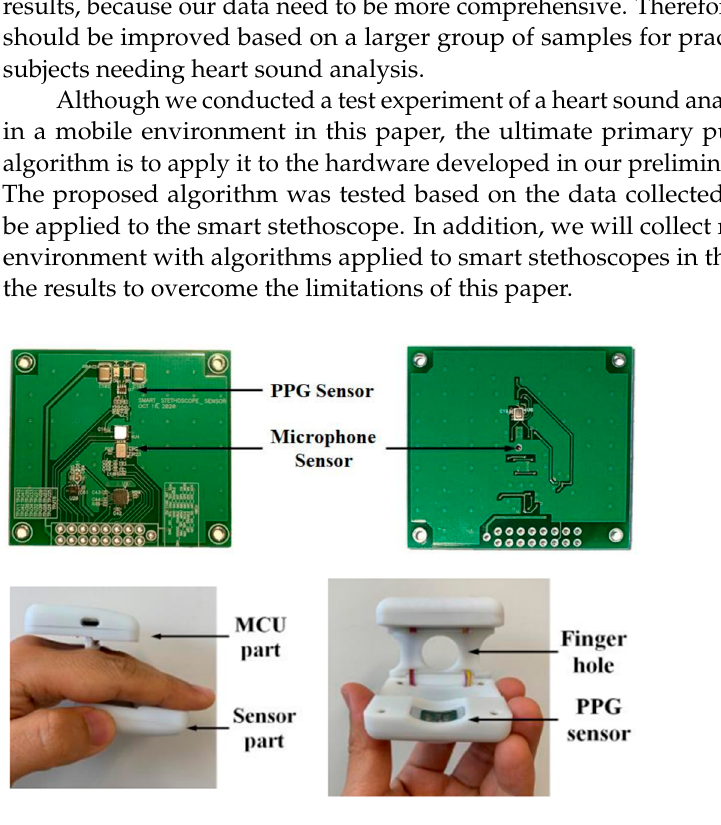
Figure 8. Our preliminary research [1] of hardware development for heart sound analysis in mobile environments. Reprinted/adapted with permission from Ref. [1]. 2021, Sensors.